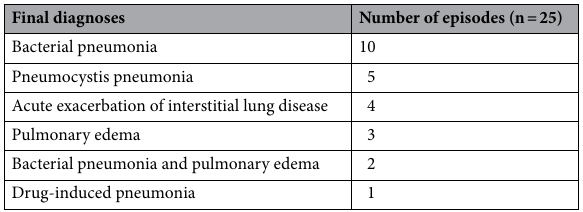
Table 2. Final diagnoses of the control patients.